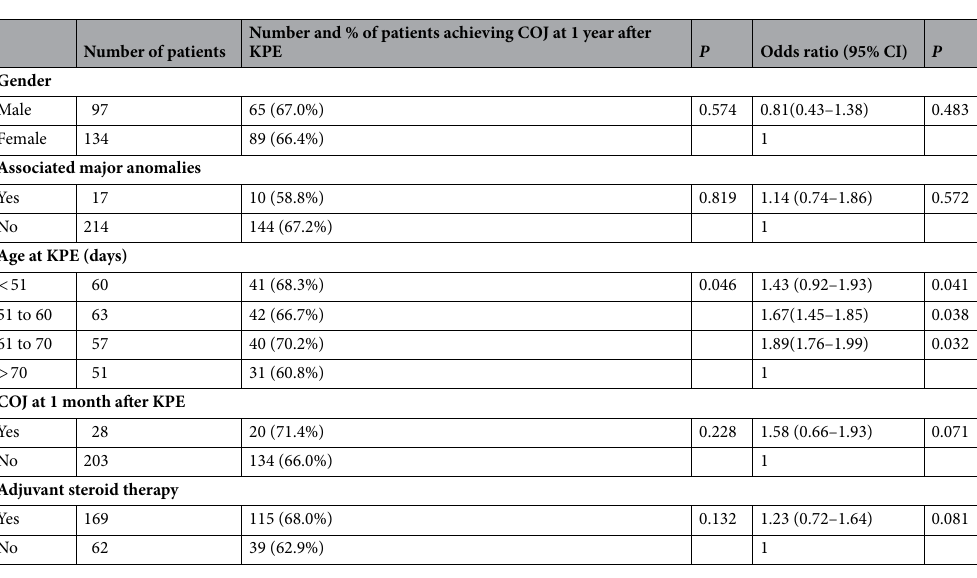
Table 2. Percentage and odds ratio from logistic regression for the relation between different clinical variables and clearance of jaundice (COJ) at 1 year after KPE (n = 154/231, 66.7%).